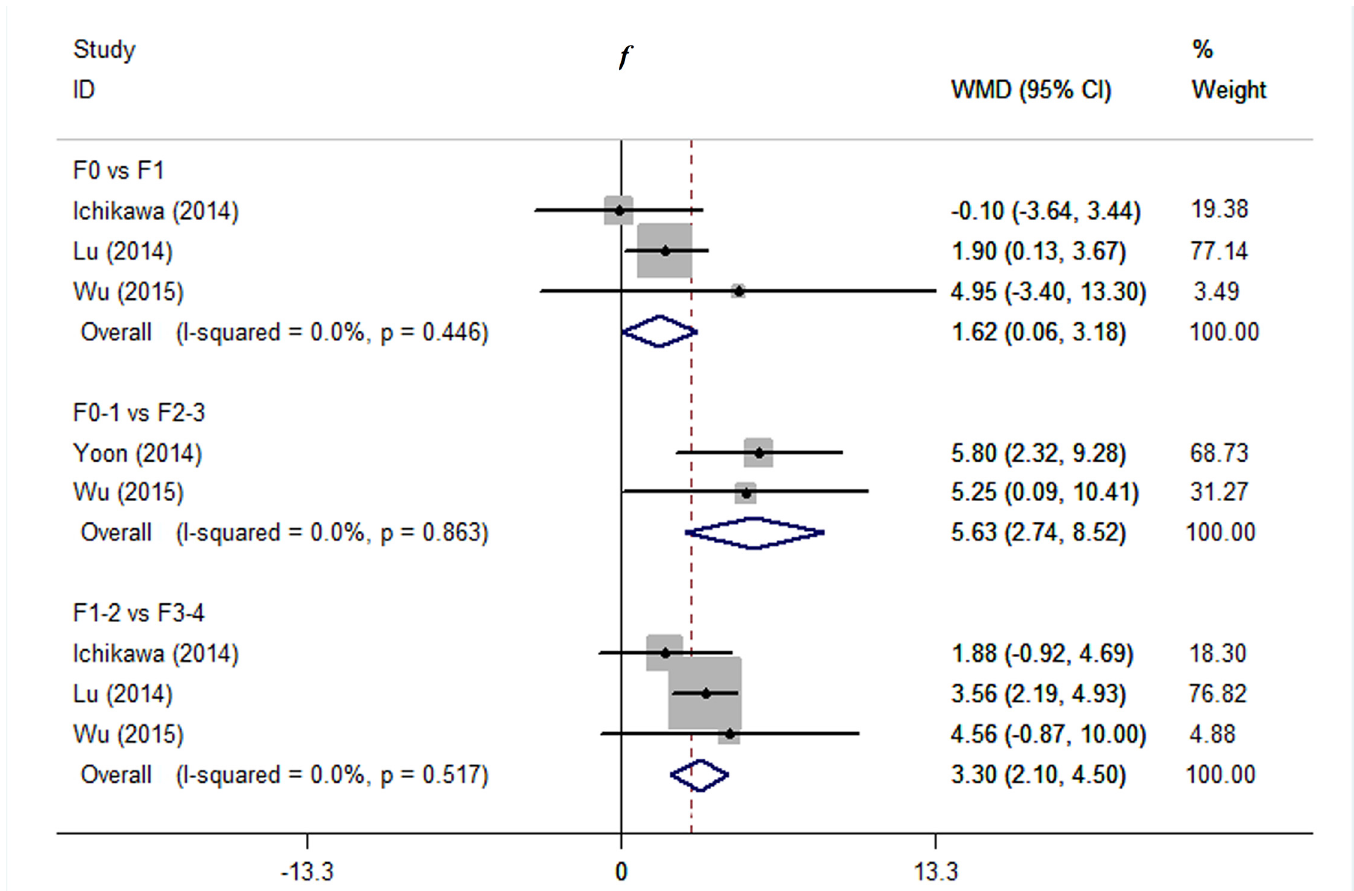
Fig 4. Comparing stage F0 with F1, F0-1 with F2-3, and F1-2 with F3-4 using f . We used influence analysis to drop a study exerted excessive influence on the overall estimate and therefore to decrease the heterogeneity. Abbreviations: WMD = weighted mean difference; CI = confidence interval.